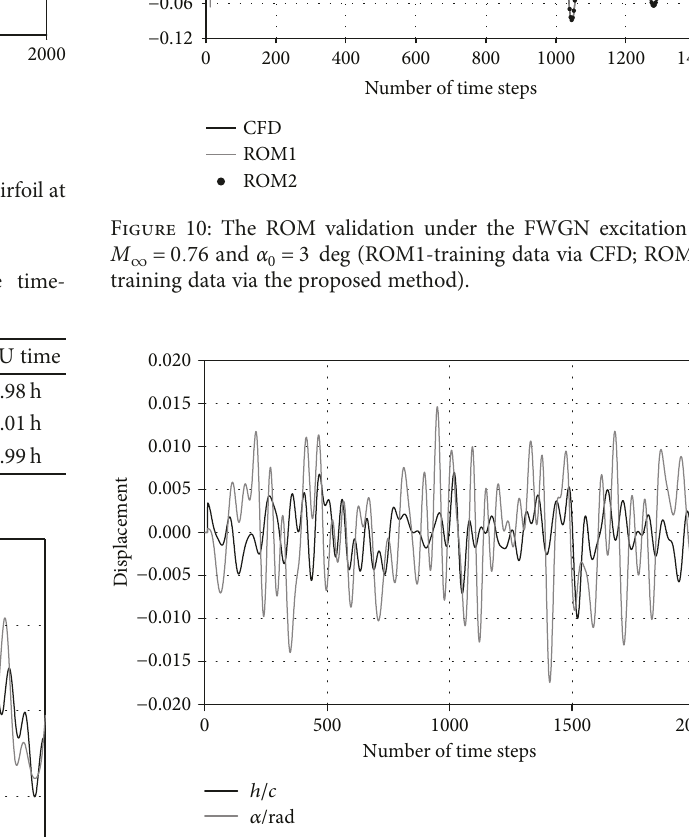
Figure 11: The FWGN excitation signals for ROM validation at M α = 5 deg ∞ = 0 82 and 0